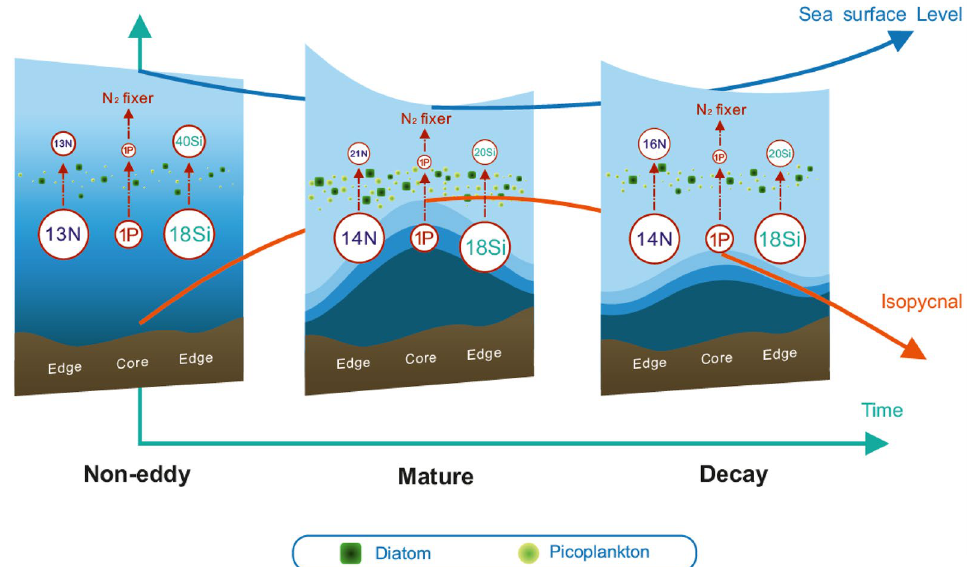
Fig. 5 Conceptual model of nutrient dynamics within eddies at different developmental stages in the cyclonic eddies of western South China Sea modified from Zhou et al. (2020). The size of the circles denotes the relative nutrient concentration; nutrient ratios are shown in the